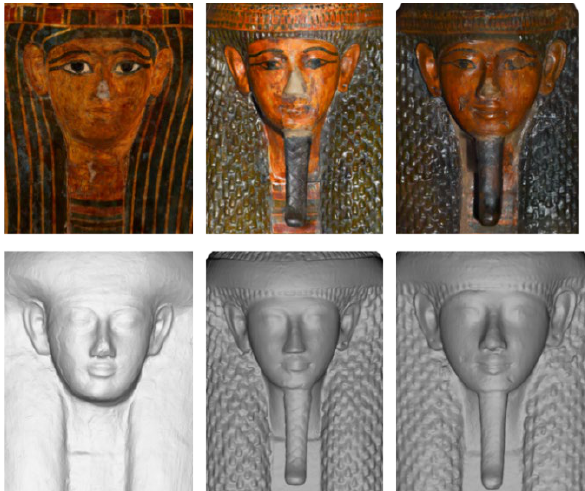
Figure 4. Coffin set of Butehamon with and without texture. From right to left: outer lid (CGT 10101.a), inner lid (CGT 10102.a) and the mummy board (CGT 10103). ©Museo Egizio di